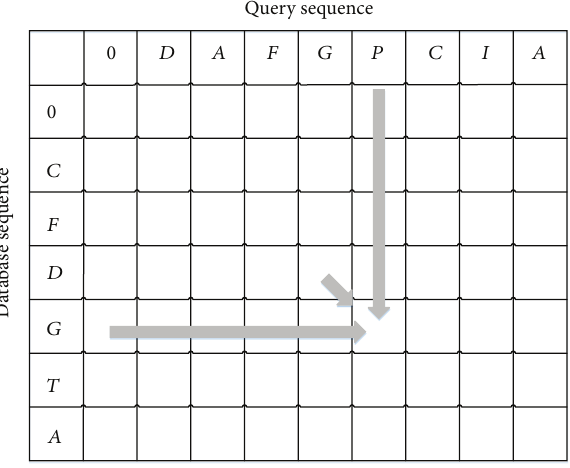
Figure 1: Dependency of calculating an alignment matrix 𝐻(𝑖,𝑗)